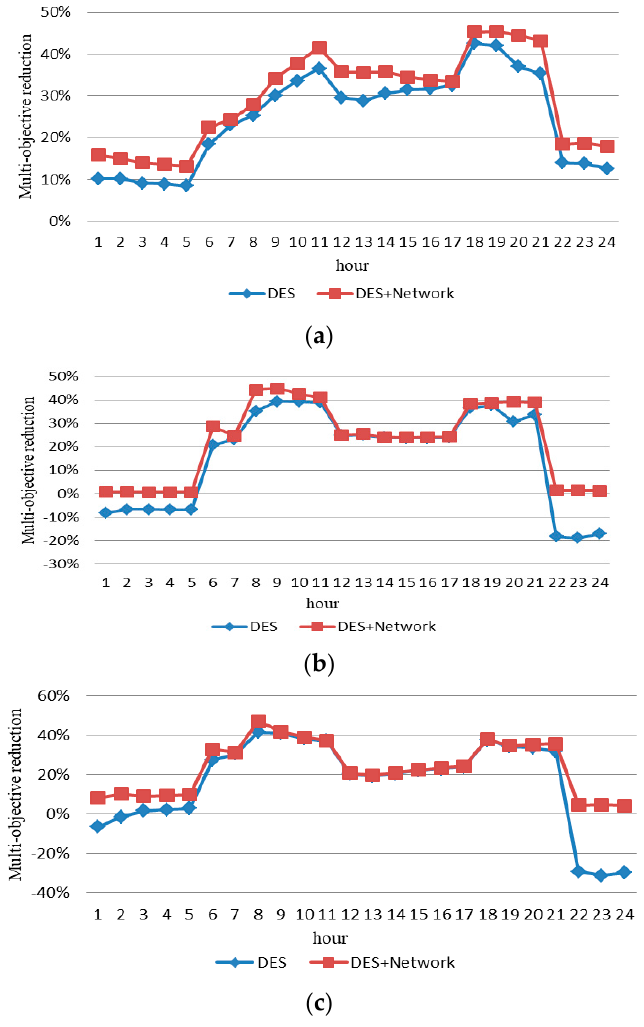
Figure 4. The objective values in DES (scenario 2) and DES + Network (scenario 3) in typical winter ( a ), summer ( b ) and mid-season ( c ) days.